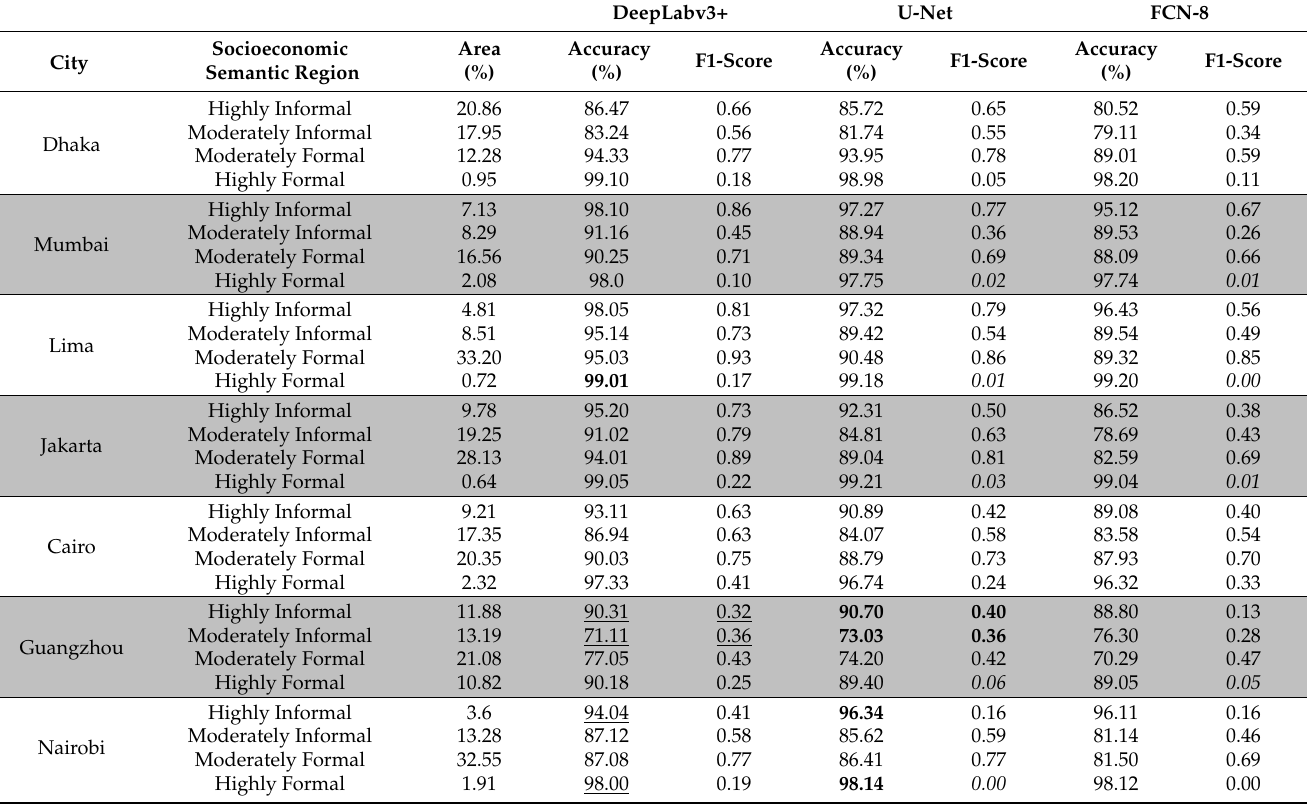
Table 2. Detailed performance of segmentation over six cities. DeepLabv3+ U-Net